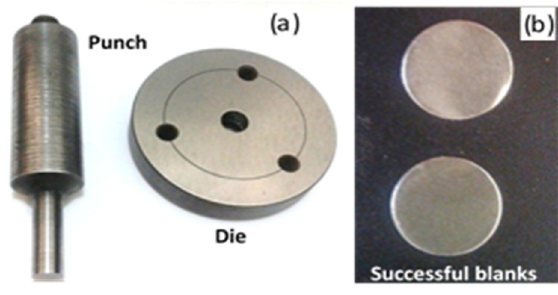
Fig. 9. (a) Blanking tools (b) Blanks of SS304 with 10mm